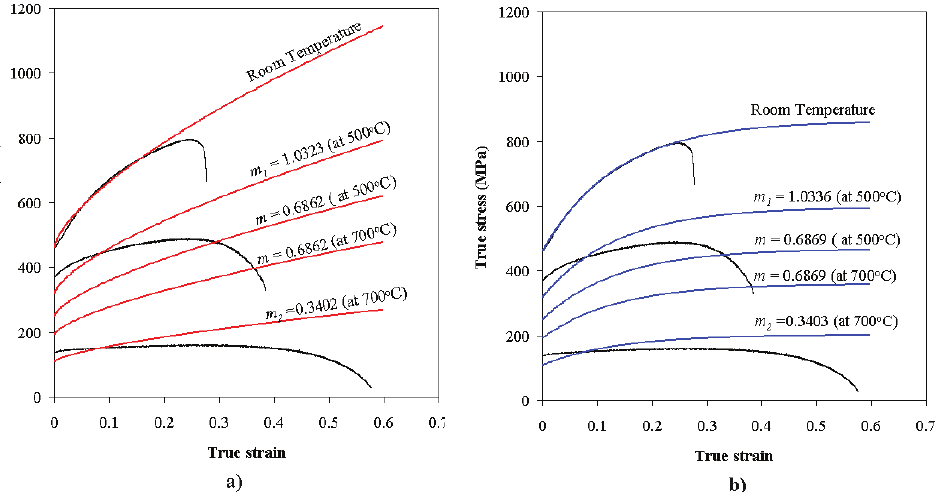
Figure 4. Predictions of J-C model at elevated temperatures with various m values based on (a) Ludwick’s and (b) Voce’s hardening law.